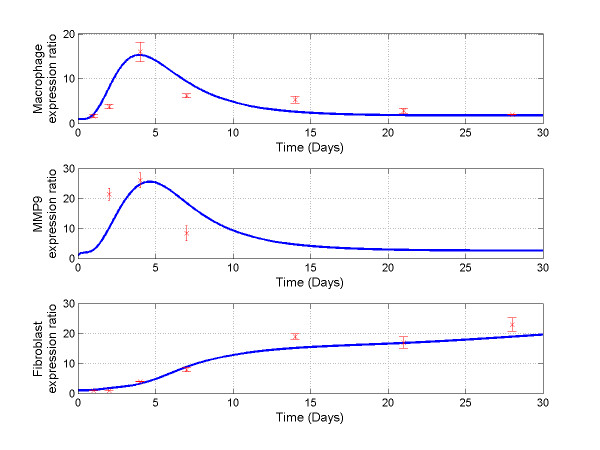
The relative ratio changes of fibroblast density, macrophage density, and MMP-9 concentrations. Computational results were normalized to initial conditions and are shown in solid lines. Previously published experimental results were normalized to the corresponding measurements in control group and are shown as x (Mean ± SD). All experiments were carried out in mice with MI induced by coronary artery ligation. The fibroblast and macrophage densities were collected from C57BL/6J mice [12]. MMP-9 profile was collected from 129SV mice [45,46].